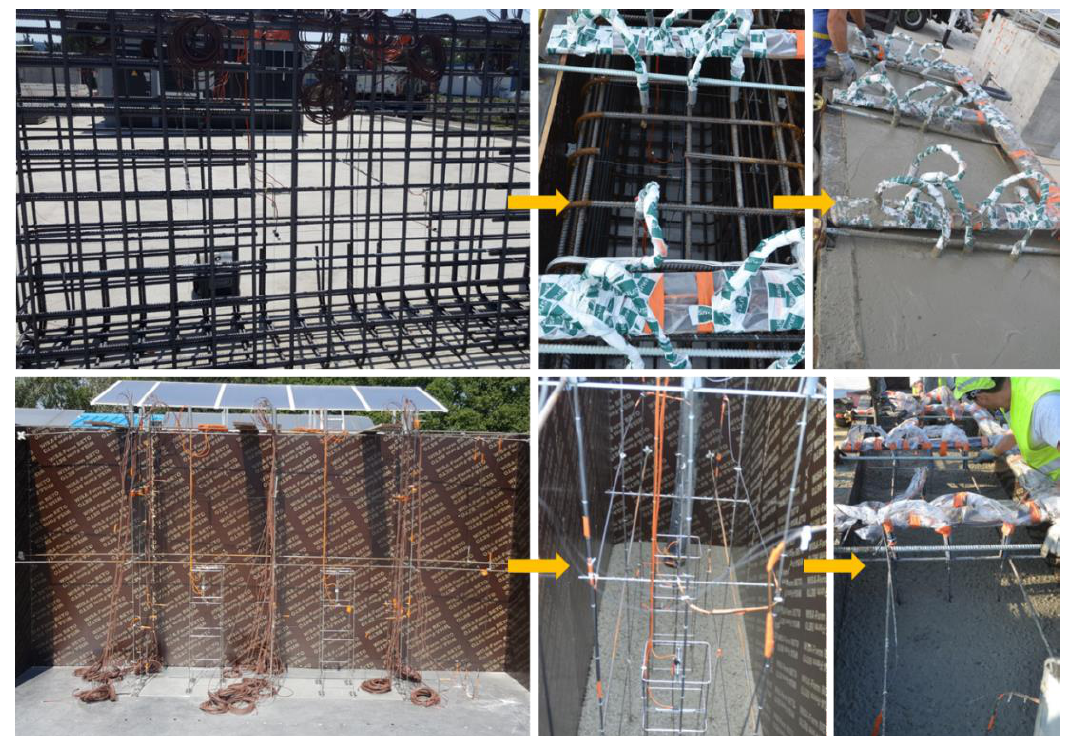
Figure 4. Construction steps of the two types of ODOBA blocks: RC blocks (top pictures) and NRC blocks (bottom pictures).